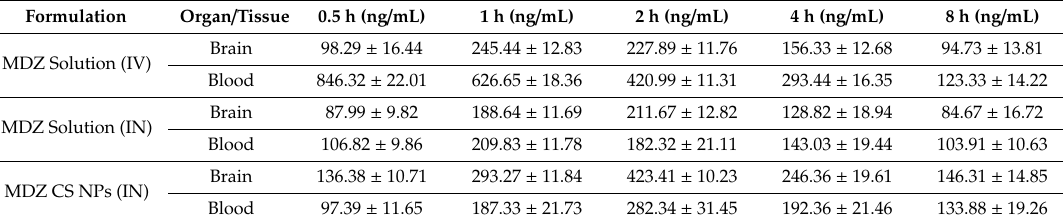
Table 4. Distribution of MDZ solution (IV), MDZ solution (IN), and MDZ CS-NPs (IN) at di ff erent time intervals in Wister rats ( n = 3).